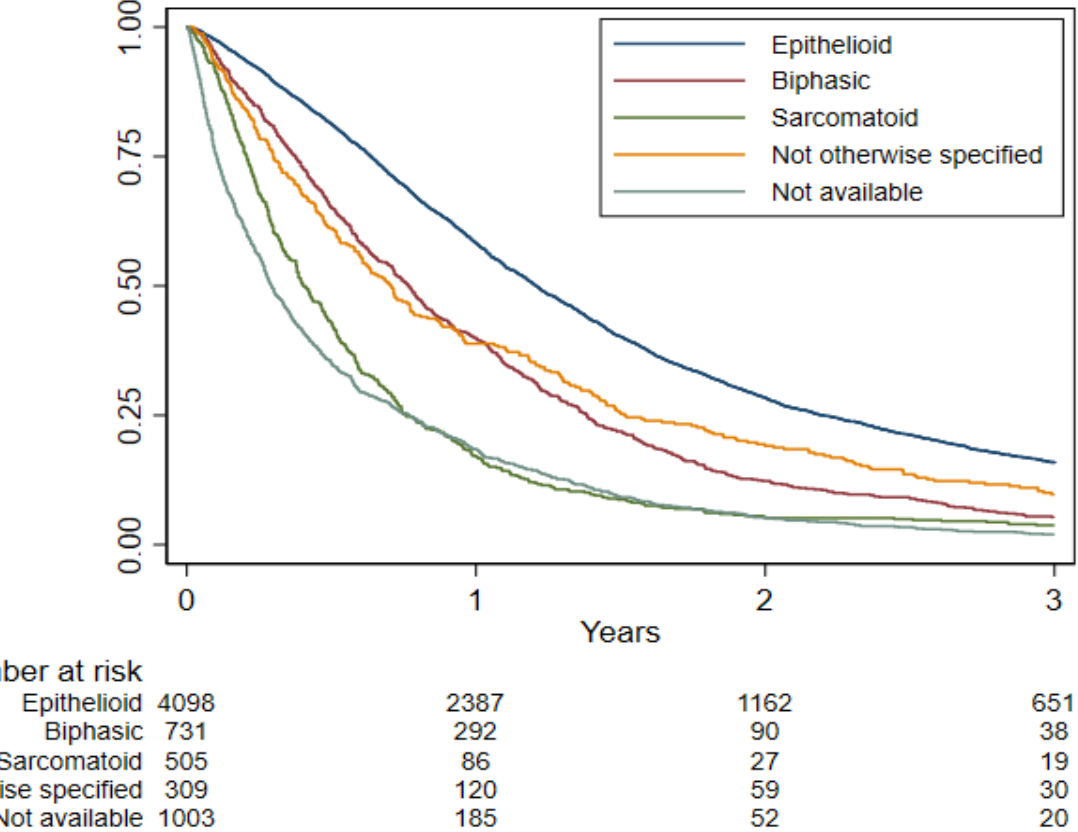
Figure 2. Overall survival by histotype estimated using Kaplan–Meier curve, Lombardy, 2000–2018. Follow-up period 2000–2021. Table 4. Prognostic factor analysis in the entire study population, Lombardy 2000–2018. Follow-up period 2000–2021.